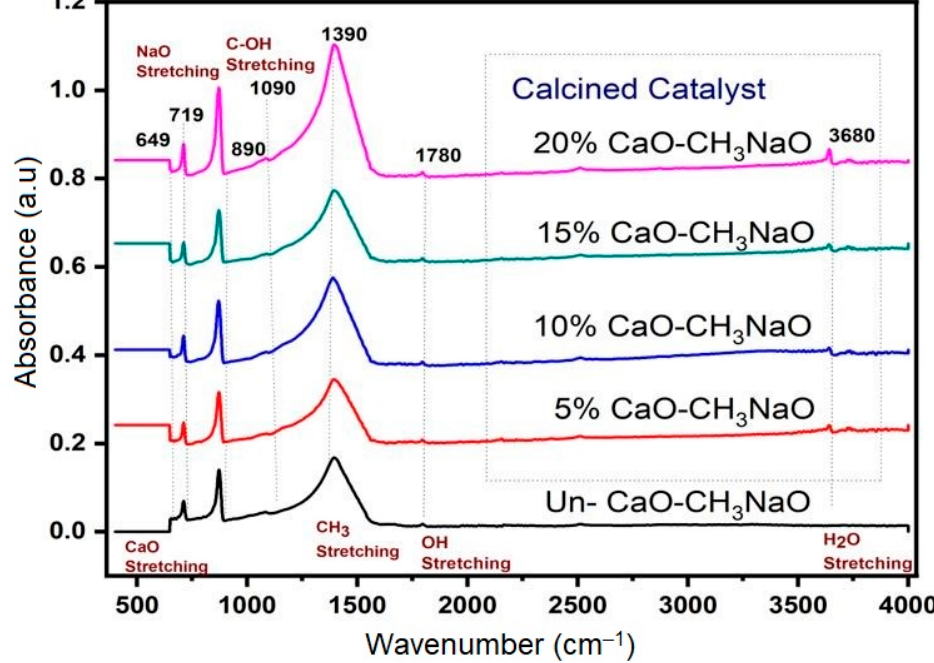
Figure 1. FTIR analysis of uncalcined and calcined CH 3 NaO-doped CaO catalyst with different doping ratios.